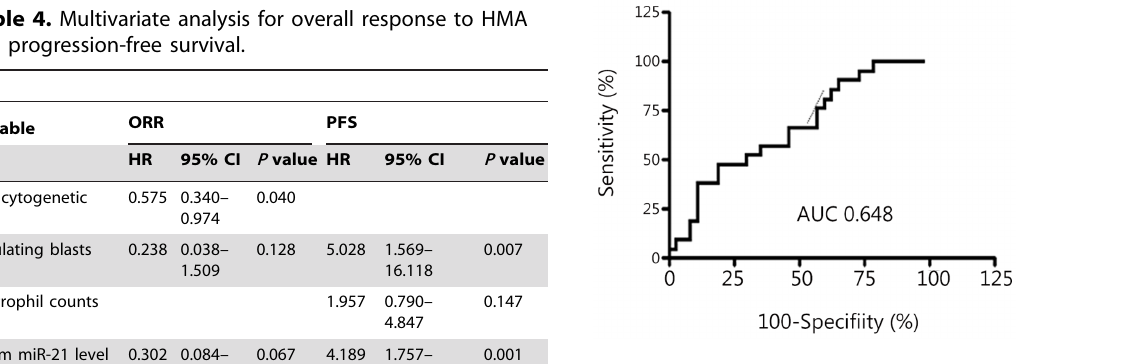
Figure 4. Kaplan-Meier curves for overall survival and pro- gression-free survival comparisons. (A) Overall survival and (B) progression-free survival according to baseline serum miR-21 levels in patients with myelodysplastic syndromes treated with hypomethylating